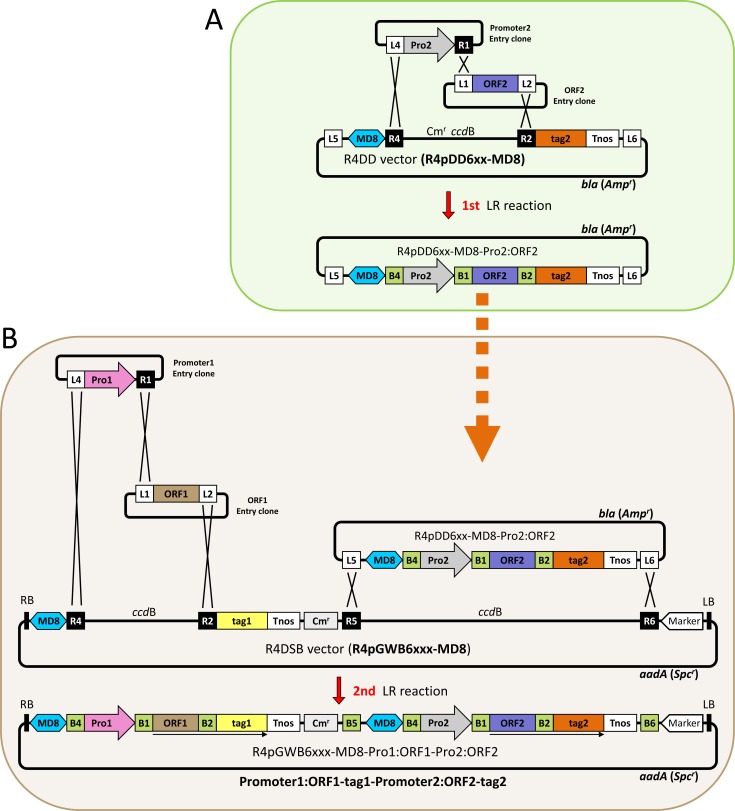
Outline for cloning two sets of promoters and ORFs in the R4DS Gateway cloning system.(A) The 1st LR reaction. In the 1st LR reaction (tripartite LR reaction), Pro2 and ORF2 are linked and cloned into an R4DD vector to make R4pDD6xx-MD8-Pro2:ORF2. The dashed arrow indicates that established R4pDD6xx-MD8-Pro2:ORF2 is used further for the 2nd LR reaction. (B) The 2nd LR reaction. In the 2nd LR reaction (quadripartite LR reaction), Pro1 and ORF1 are linked and cloned into an R4DSB vector together with the Pro2:ORF2-tag2 constructed by the 1st LR reaction to make the binary clone R4pGWB6xxx-MD8-Pro1:ORF1-Pro2:ORF2 with two independent expression cassettes. MD8, the matrix attachment region; B1, attB1; B2, attB2; B4, attB4; B5, attB5; B6, attB6; L1, attL1; L2, attL2; L4, attL4; L5, attL5; L6, attL6; R1, attR1; R2, attR2; R4, attR4; R5, attR5; R6, attR6; ccdB, Control of Cell Death B as a negative selection marker for bacteria; Cmr, chloramphenicol resistance; Marker, plant selection marker; Pro1, promoter1; Pro2, promoter2; LB, left border; RB, right border; Tnos, nopaline synthase terminator; aadA, the gene for spectinomycin resistance (Spcr) in bacteria; bla, gene for ampicillin resistance (Ampr) in bacteria. Arrows under ORF1-B2-tag1 and ORF2-B2-tag2 indicate expression. Figures are not drawn to scale.